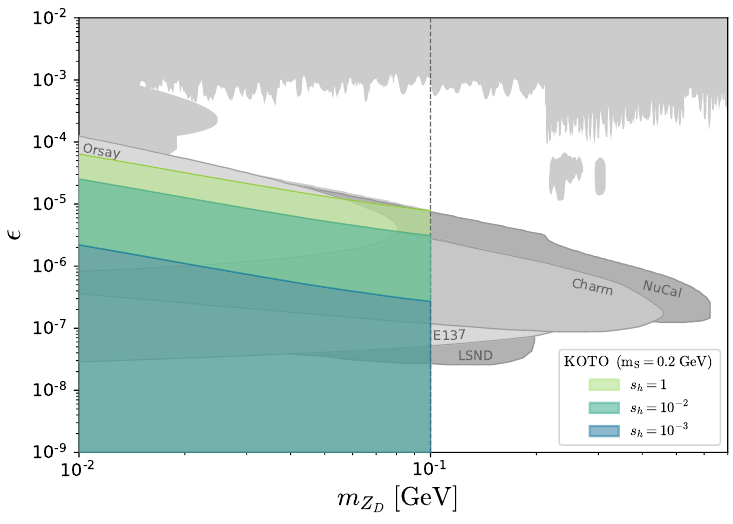
Figure 5 . Limits from KOTO translated to the dark photon parameter space of the HAHM, where we have fixed m S = 0 . 2 GeV and colored regions are excluded for s h = 1 (light green), 10 − 2 (green) and 10 − 3 (blue green). The regions extend down to (cid:15) = 0 . The other gray bounds are dark